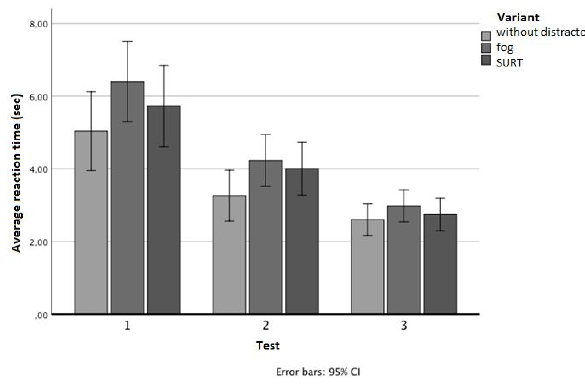
Figure 1: Average distractor variant-dependent test times, N =